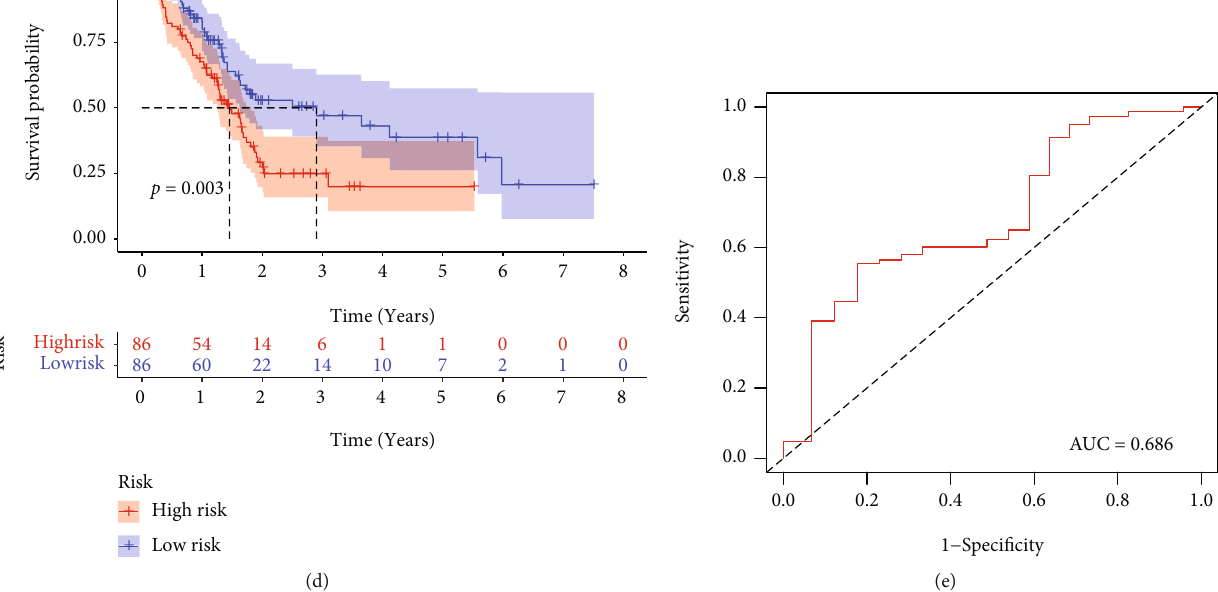
Figure 4: Development of the TF-based prognostic signature in PAAD. (a – c) Distributions of four-gene expression pro fi les of each patient, risk scores, and survival statuses of patients in the low-risk and high-risk groups. (d) Kaplan-Meier assays of the TF-related signature displaying worse survivals in the high-risk group. (e) ROC curve is applied to determine the diagnostic value of our